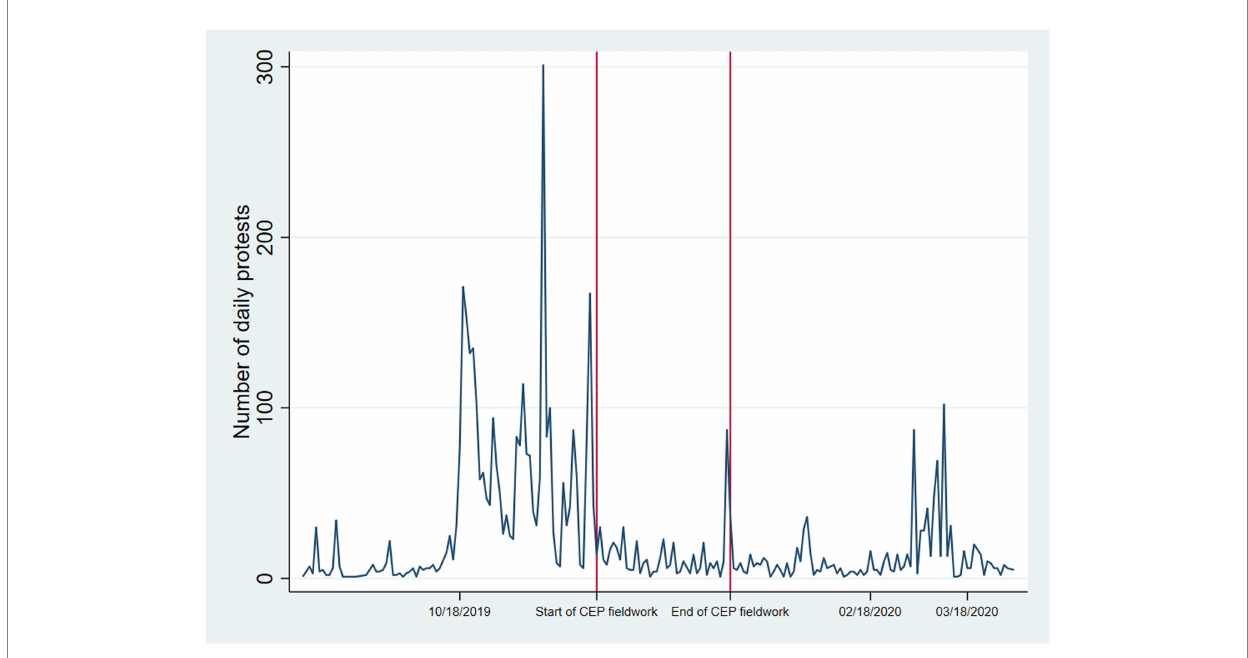
FIGURE 1 Frequency of protests during the 2019 Chilean unrest and CEP fieldwork